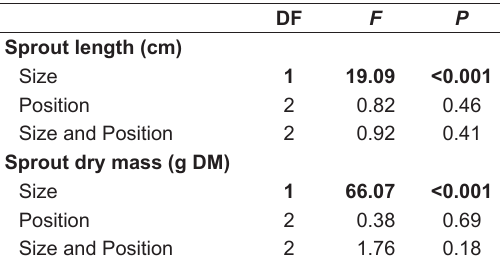
Table 1. Two-way ANOVA results for effect of parental propagule size (large and small plants) and position (apical, intermediate and basal portions) on sprout length and dry mass (N =